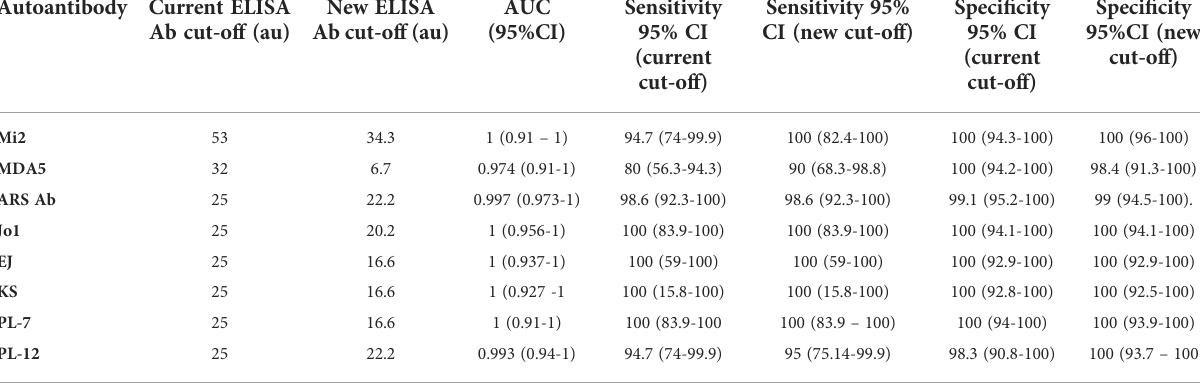
TABLE 3 New sensitivity and speci fi city of autoantibodies using Youden ’ s Index for optimal cut-off points in our cohort of patients. Autoantibody Current ELISA Ab cut-off